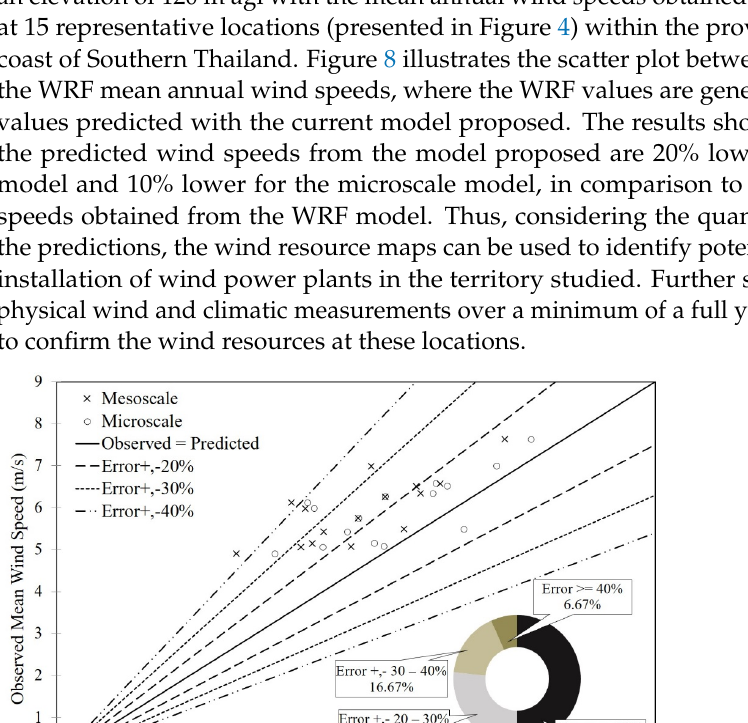
Figure 7. Microscale wind resource map at 140 m agl for the western coast of Southern Thailand.